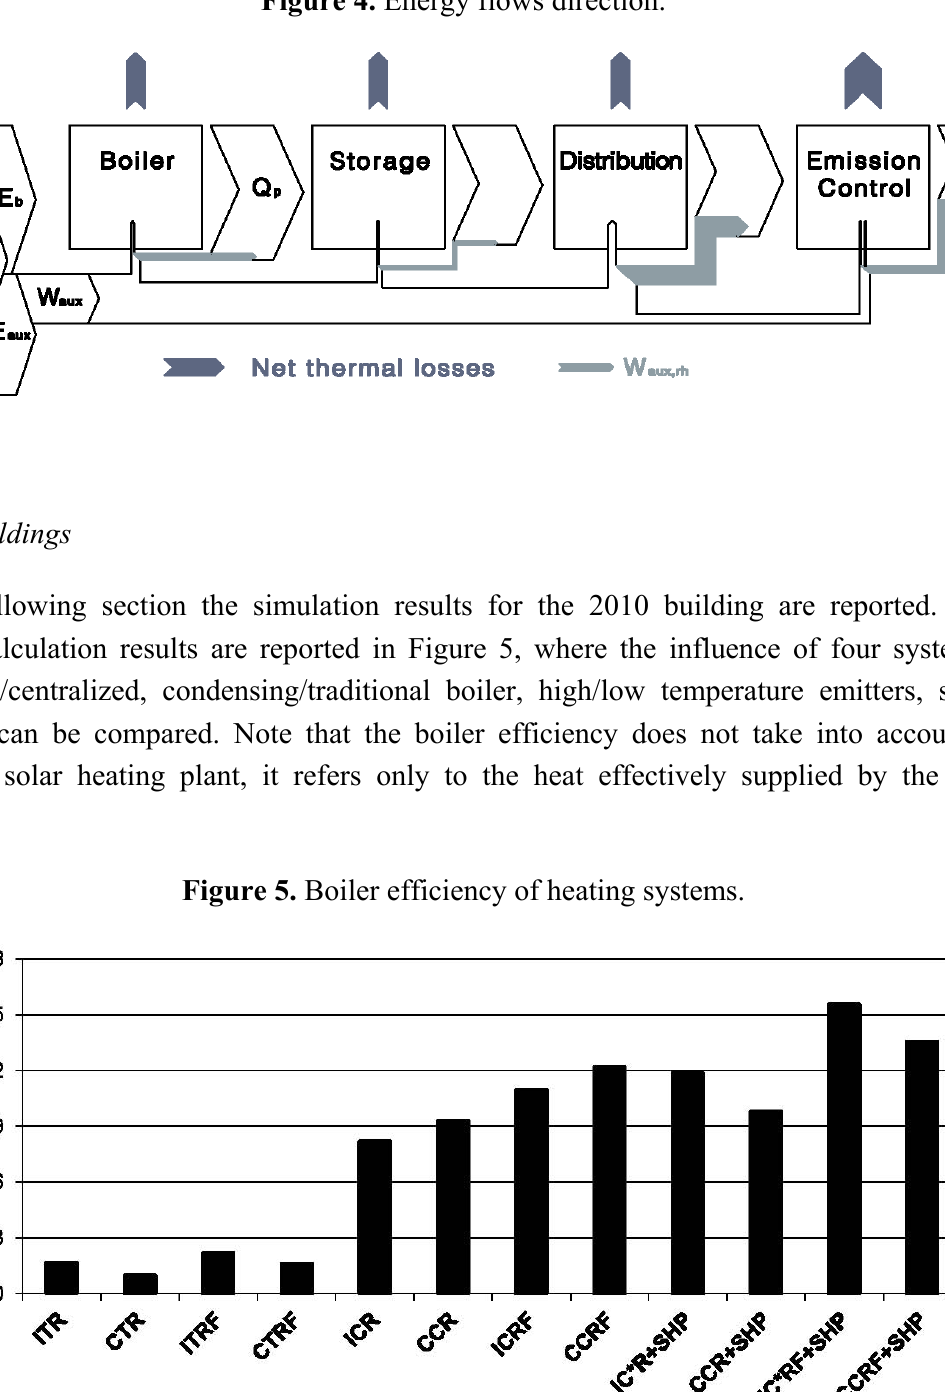
Figure 4. Energy flows direction.